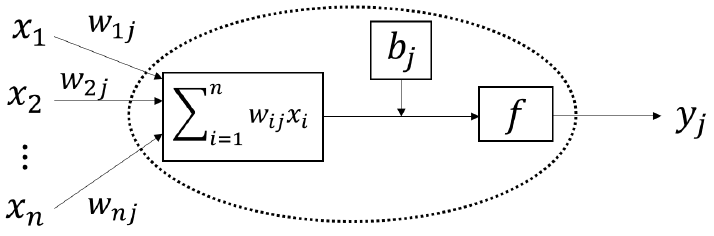
Figure 1. A single artificial neuron process.